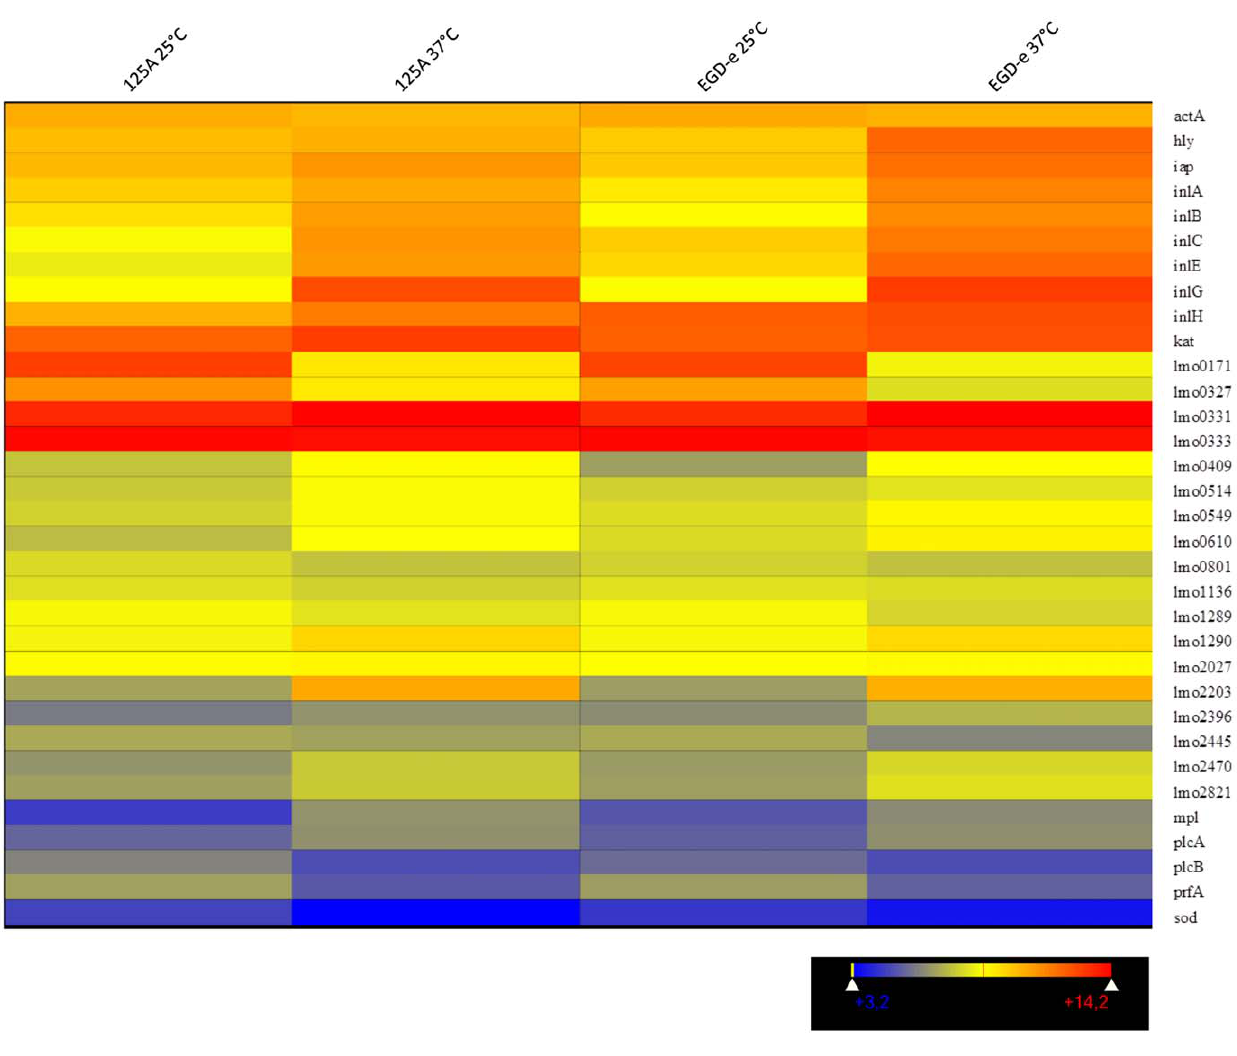
Figure 3. Heatmap of virulence genes.